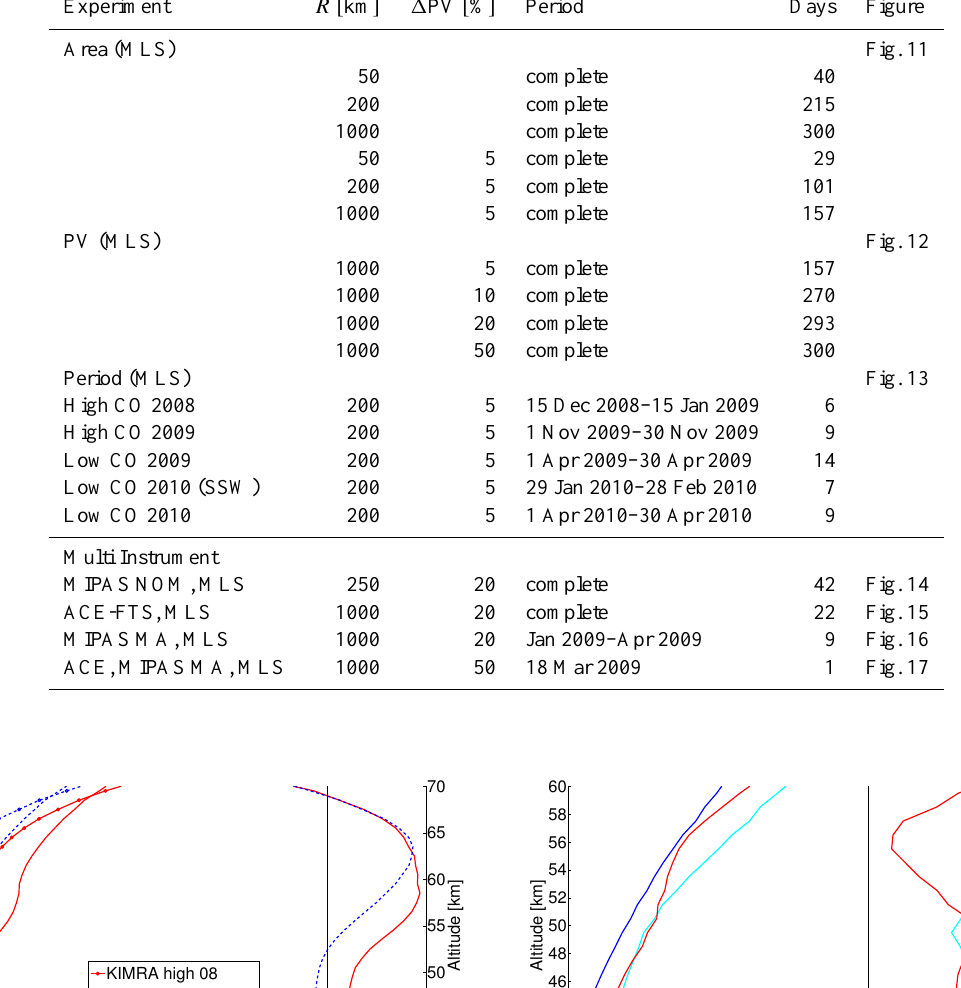
Table 5. Summary of setups of the satellite comparison experiments.